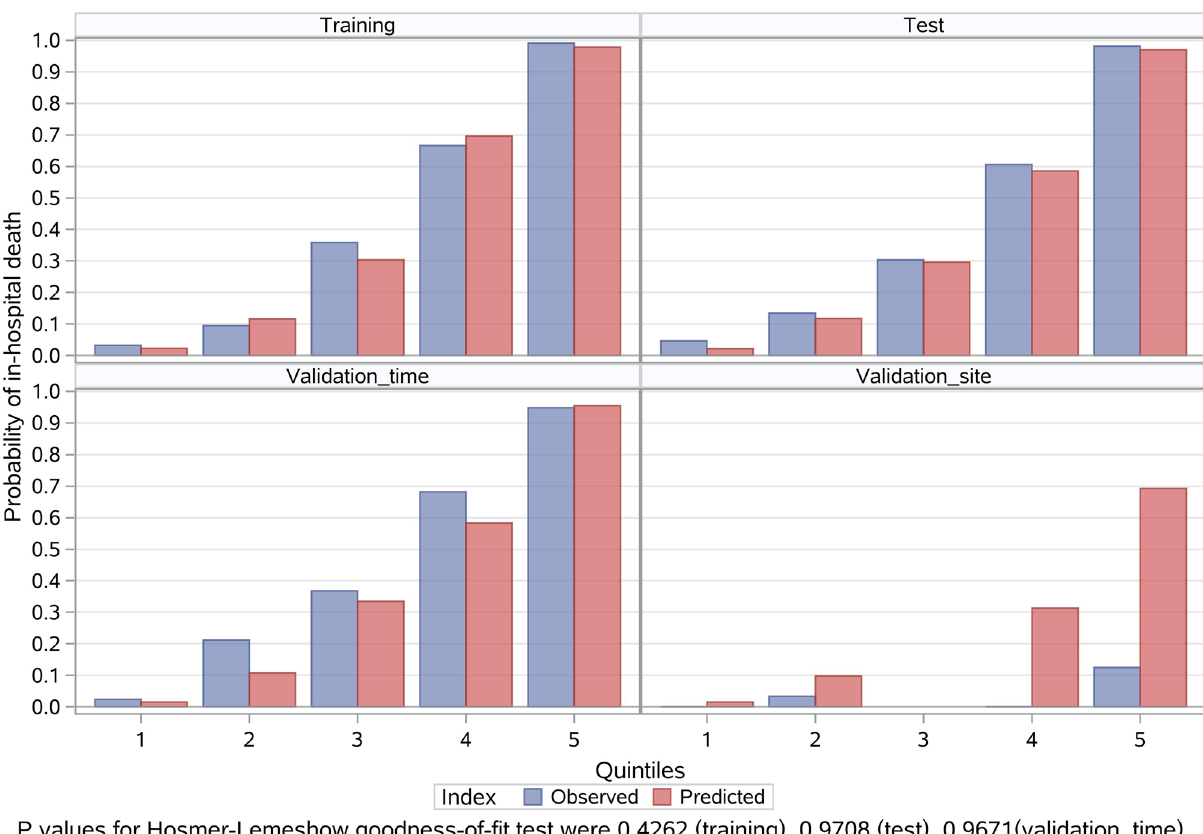
Figure 5. Observed versus predicted values by quintiles in the training, test, validation_time, and validation_ site groups. The Hosmer and Lemeshow’s Goodness of Fit Test’ p-values were 0.4262, 0.9708, 0.9671, and 0.9999 for the training, test, validation_time, and validation_site samples,